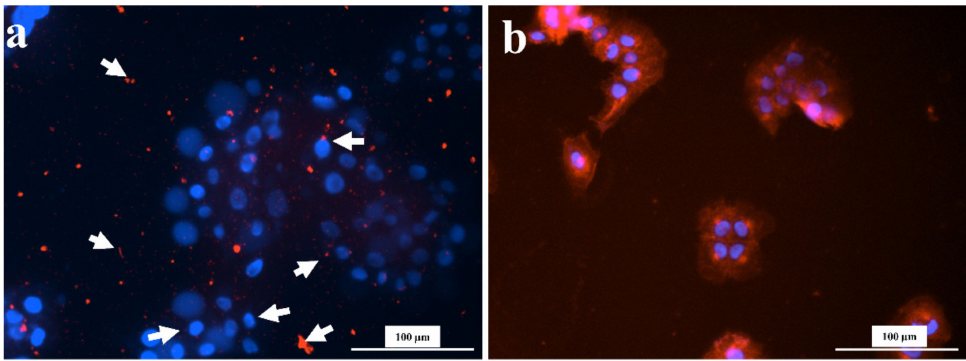
Figure 6. Morphological images (Cytation 3, 20 × ) of HaCaT cells after 12 h of treatment with 1.5 mg/mL of ( a ) tea and ( b ) coffee extracts. All images were recorded under the same conditions and presented with the same magnification for